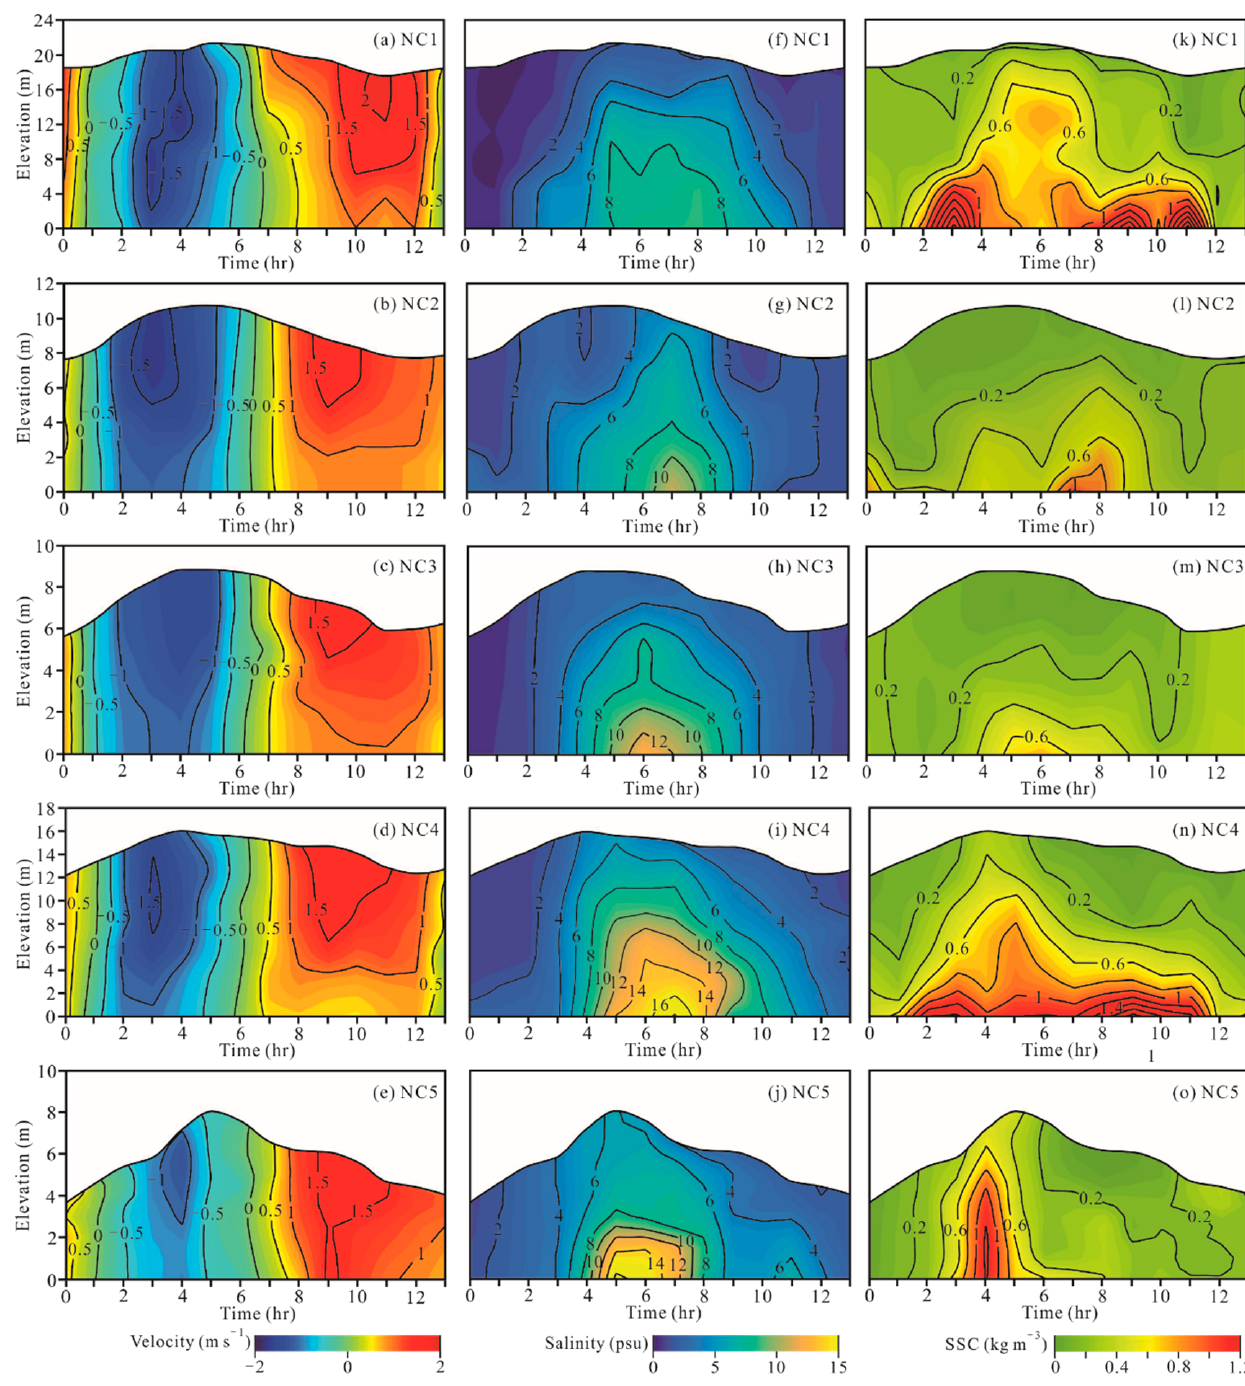
Figure 2. Temporal variations of current velocities (m s − 1 ) ( a – e ), salinities (psu, practical salinity unit) ( f – j ) and SSC (kg m − 3 ) ( k – o ) at NC1 to NC5 stations. The vertical profile of velocity was obtained by acoustic Doppler current profiler (ADCP, Teledyne RDI. WHR-600) with acoustic wave frequency of 600 kHz; the water depth was obtained by bottom tracking mode. During the observation, the ADCP was fixed on one side of the boat using a steel fixing frame; the transducer was at 0.5 m below the water surface. The blanking distance of the ADCP was 0.25 m, the cell size of velocity profile was 0.5 m, the sampling interval was 2 s. The optical backscatter sensor (OBS) and conductivity–temperature–depth (CTD) were winched from surface to bottom every half hour to obtain vertical profiles of turbidity and salinity with sampling intervals